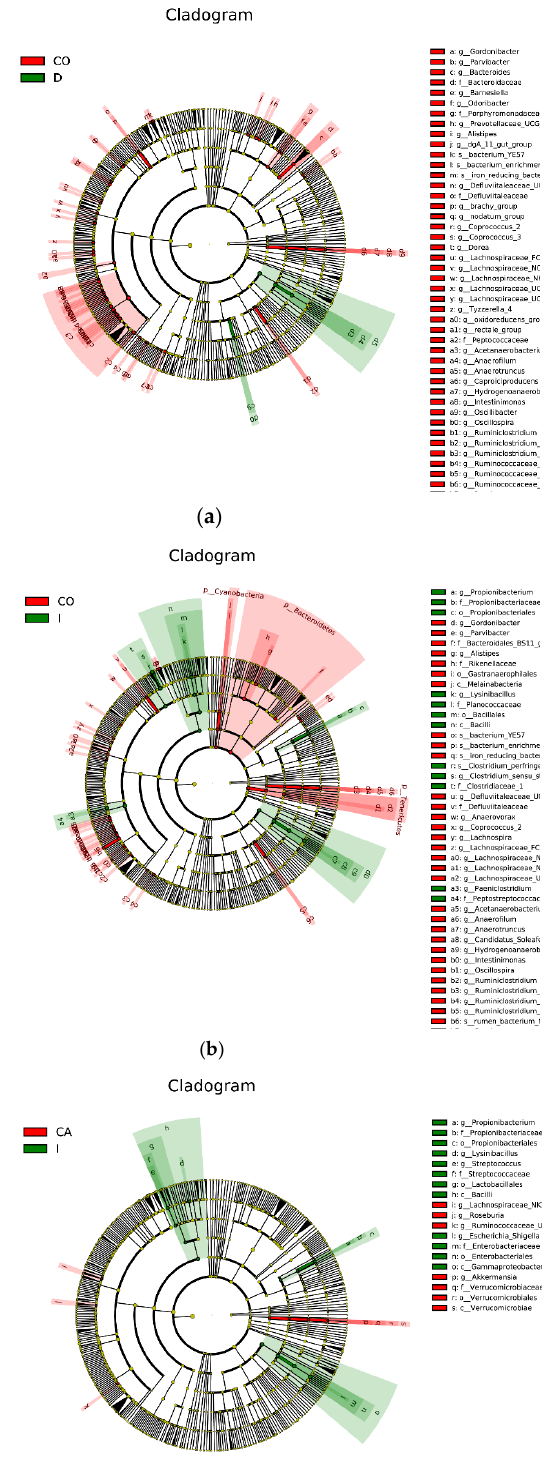
Figure 5. The evolutionary branching graph was obtained by LEfSe. In the evolutionary cladistic diagram, the circle of radiation from inside to outside represents the taxonomic level from phylum to genus (or species). Yellow means no significant difference. ( a ) LEFse difference analysis of duodenum (D) and colon (CO); ( b ) LEFse difference analysis of Ileum (I) and colon (CO); ( c ) LEFse difference analysis of Ileum (I) and Caecum (CA).